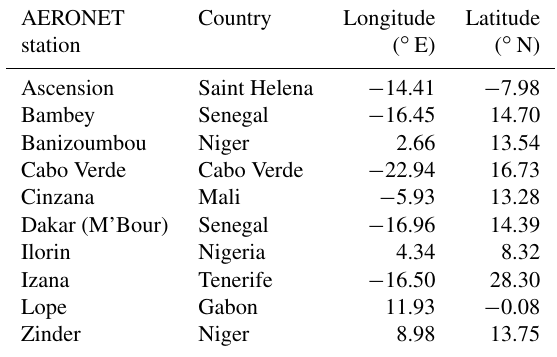
Table 1. AERONET measurement stations with their names, coun- tries, and coordinates (sorted by alphabetical